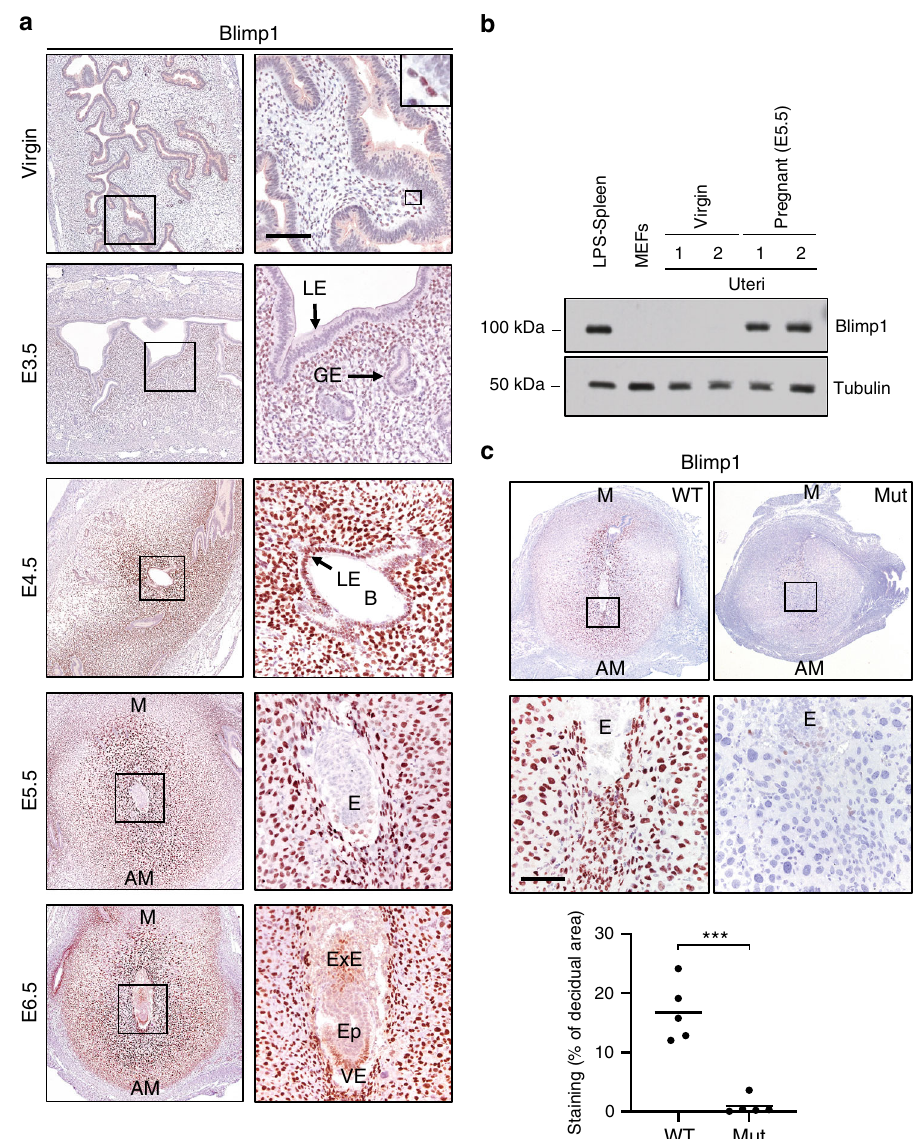
Fig. 1 Induction of Blimp1 protein expression during pregnancy and PR-Cre-driven deletion in decidual tissues. a Blimp1 IHC in virgin, E3.5, E4.5, E5.5 and E6.5 wild-type uteri. In virgins, Blimp1 was detected in a small number of cells underlying the luminal epithelium. Upon fertilisation, Blimp1 was induced in uterine stroma (E3.5) followed by strong upregulation at the site of implantation in both the decidualising stroma and luminal epithelium (E4.5-E6.5). Results are representative of triplicate staining experiments performed using independent samples. b Western blot analysis con fi rmed strong induction of Blimp1 protein in the uterus during pregnancy. Source data are provided as a Source Data fi le. Duplicate experiments were performed with comparable results. c IHC con fi rms loss of Blimp1 protein in decidual stromal cells in Blimp1 mutant mice at E6.5. Data from 5 tissue sections from triplicate decidual samples per genotype. Source data are provided as a Source Data fi le. Bars represent mean. Two-tailed unpaired Student ’ s t -test *** p = 1.36 × 10 − 4 . LE = luminal epithelium, GE = glandular epithelium, B = blastocyst, E = embryo, ExE = extra-embryonic ectoderm, Ep = epiblast, VE = visceral endoderm, M = mesometrial, AM = antimesometrial. Scale bar = 100 μ